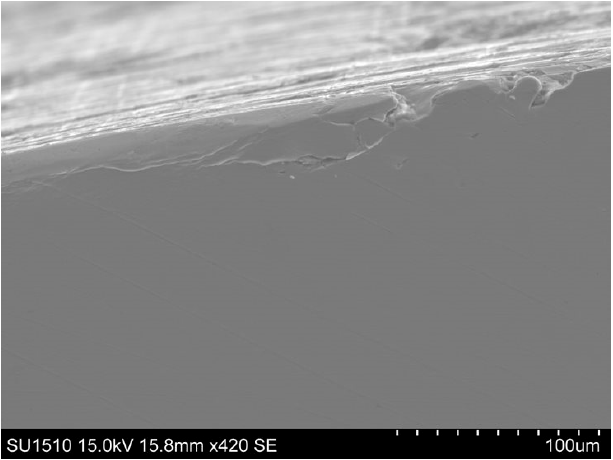
Figure 18. An electron microscopic cross-cut image of sample A1 , after sliding friction diamond burnishing. A significant reduction of surface irregularities,